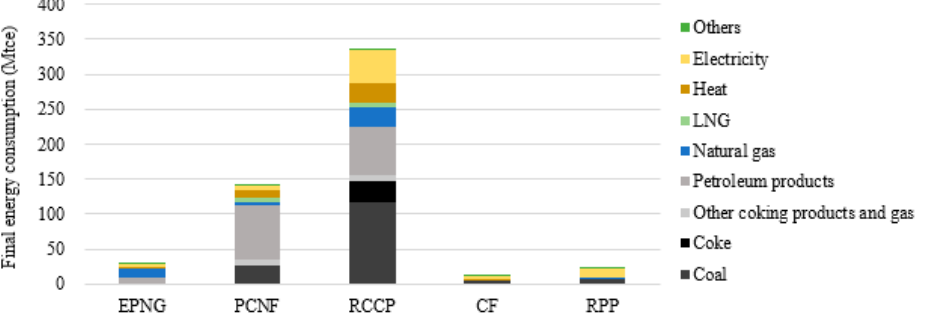
Figure 1. Final energy consumption by petrochemical industry in 2012.